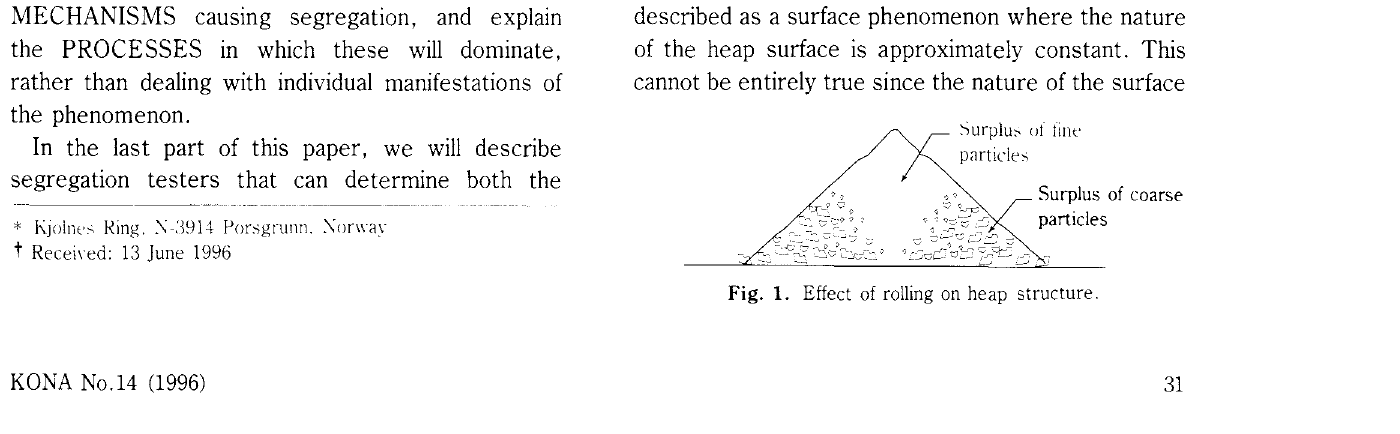
Fig. 1. Effect of rolling on heap